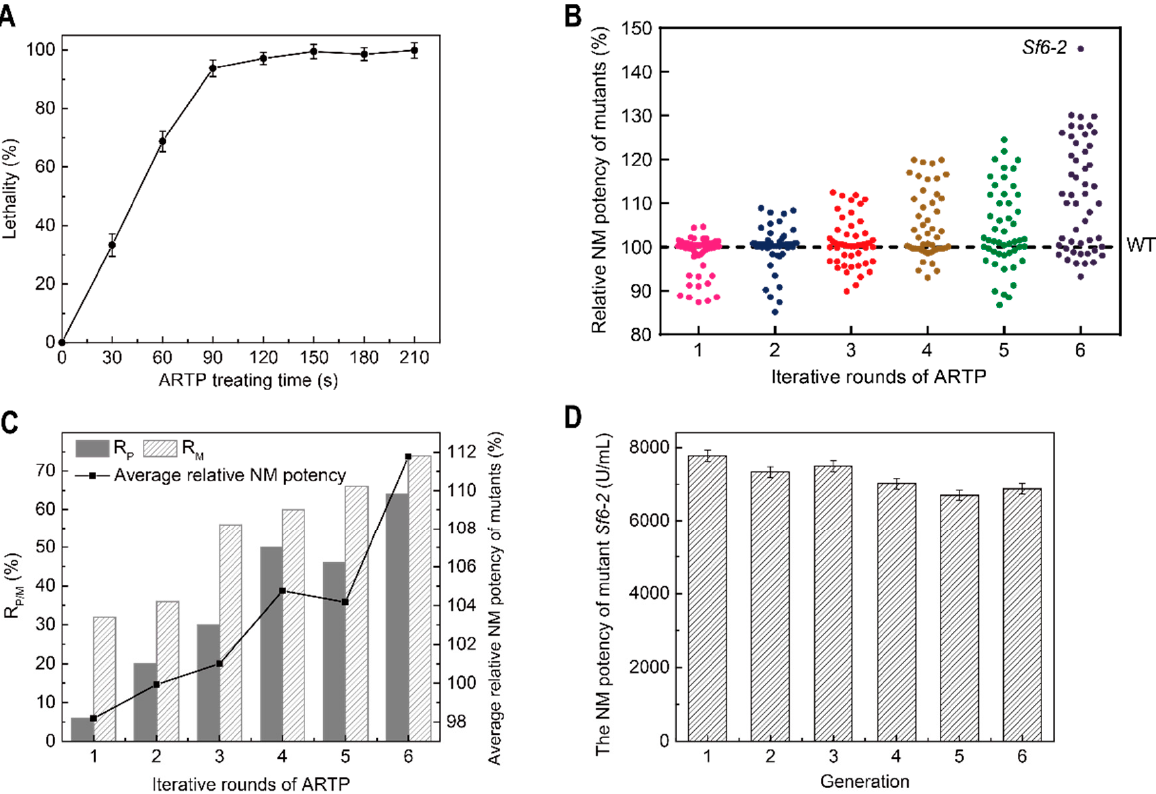
Figure 5. Iterative ARTP mutagenesis and investigations of genetic stability. ( A ) A S. fradiae lethality plot by ARTP mutagenesis; ( B ) The distribution of mutant strains with different NM potencies in each ARTP round; ( C ) The cumulative effects of iterative ARTP mutagenesis on NM potency in mutant strains; ( D ) Genetic stability of the high-producing NM mutant strain, Sf 6-2. WT: wild-type strain ( S. fradiae GC 6010); R P : positive mutation rate; R M : mutation rate; R P/M : R P and R M .